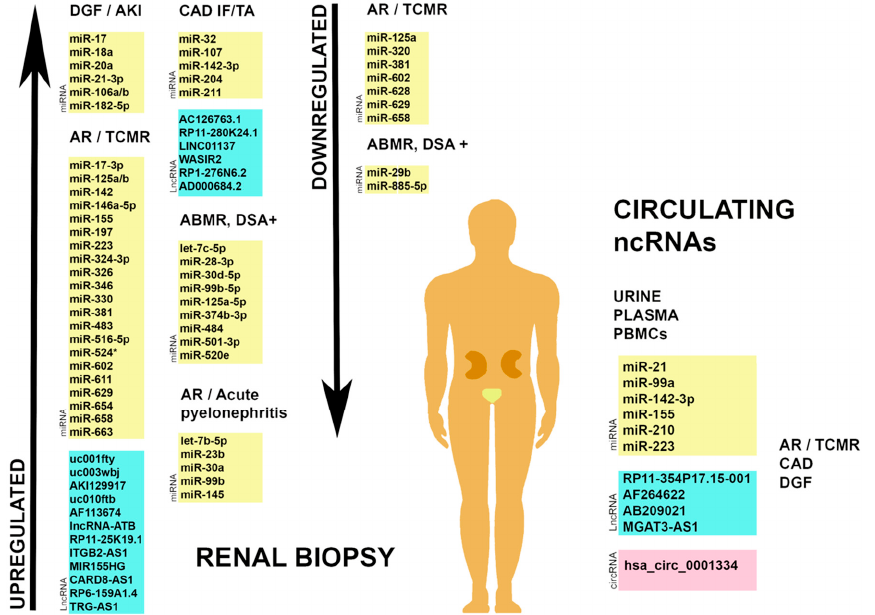
Figure 1. Renal and circulating non-coding RNAs in transplantation. Multiple studies have described molecular signatures of ncRNAs, as well as individual miRNAs, lncRNAs and circRNAs associated with disease states post-transplantation. Their study could lead to improved diagnosis of transplantation outcomes while simultaneously o ff ering an insight into the pathogenesis of renal disease often developed in these patients. miRNA, microRNA; lncRNA, long non-coding RNA; circRNA, circular RNA; DGF, delayed graft function; AKI, acute kidney injury; AR, acute rejection; TCMR, T-cell-mediated rejection; CAD, chronic allograft dysfunction; IF / TA, interstitial fibrosis and tubular atrophy; ABMR, antibody-mediated rejection; DSA, donor specific